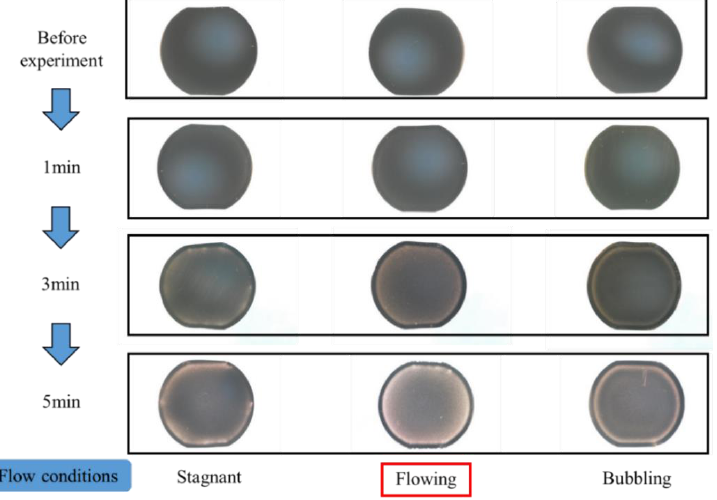
Figure 5. Surface appearance of the specimen before and after experiments.